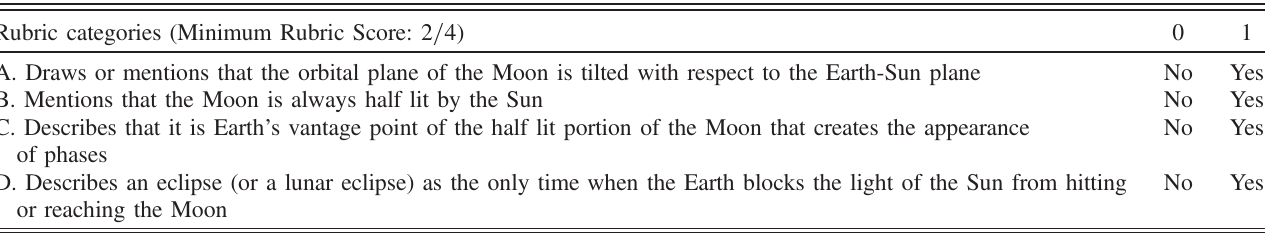
TABLE XVII. Rubric used to determine rubric scores for open-ended responses given to the assessment shown in Fig. 14. Rubric categories (Minimum Rubric Score: 2 = 4 ) 0